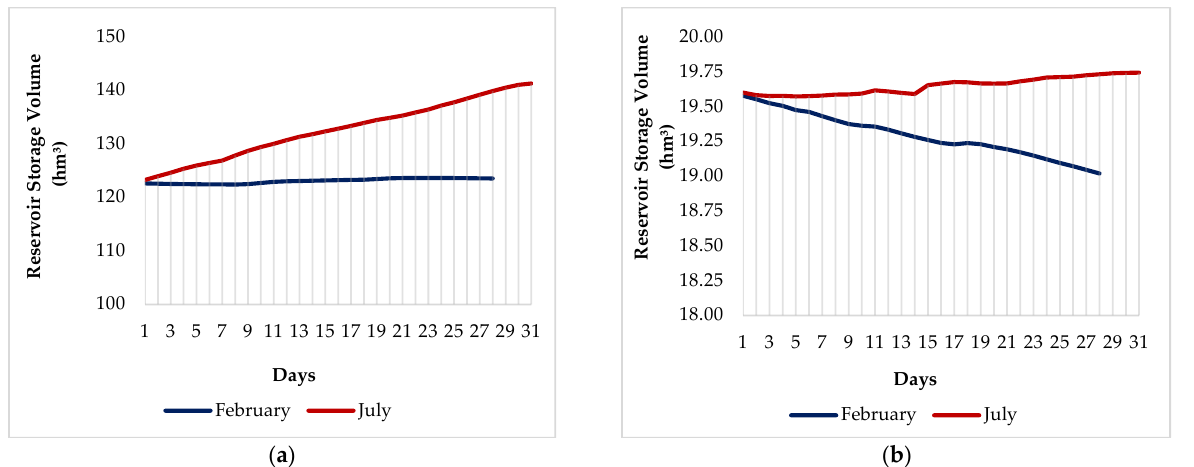
Figure 8. Accumulation volume throughout the month with the uptake defined by the DSS from ( a ) Jucazinho reservoir and ( b ) Prata reservoir.